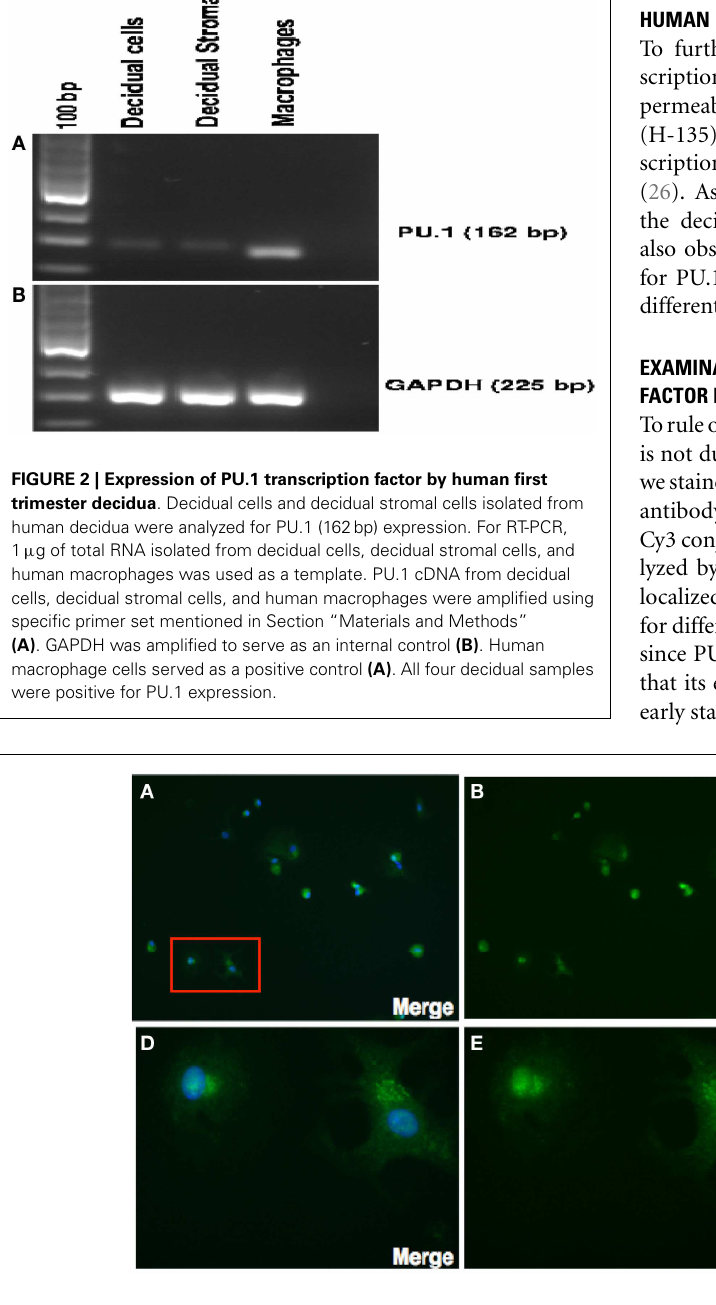
FIGURE 3 | Immunofluorescence staining for PU.1 expression in first trimester decidua . Decidual cells cytospun were fixed, permeabilized, immunostained with rabbit anti-human PU.1 antibody, and then probed with goat-anti-rabbit FITC. After counterstaining with DAPI, analysis was carried